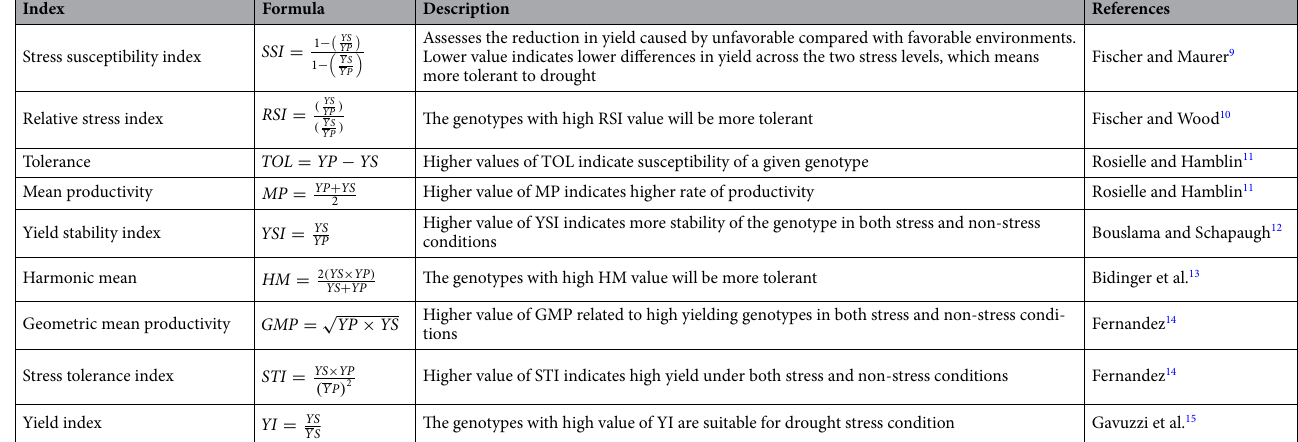
Table 2. The used tolerance and susceptibility indices in this study with their mathematical formulas. YP and YS: grain yield of a genotype under non-stress and drought stress condition, respectively. YP and YS : average grain yield over all rice genotypes under non-stress and drought stress condition,